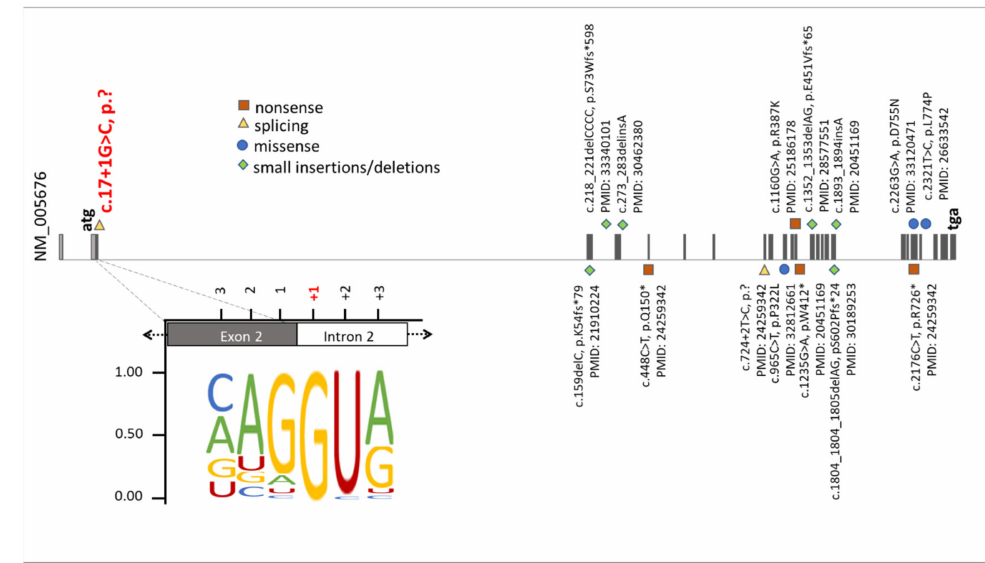
Figure 5. Summary of known mutations in the RBM10 gene. The presentation of RBM10 mutations was prepared on the bases of data from the HGMD professional, release 4955. The green diamonds, orange squares, blue circles, and yellow triangles correspond to small insertions/deletions, nonsense mutations, missense mutations, and splice variants, respectively. Additionally, the position of the novel splice variant described herein (NM_005676: c.17+1G>C, p.?) was highlighted on red. The representation of the canonical donor splice sites [26] showed the highest nucleotide conservation at +1. This emphasizes that an exchange of the +1 nucleotide is likely to cause mis-splicing of RBM10